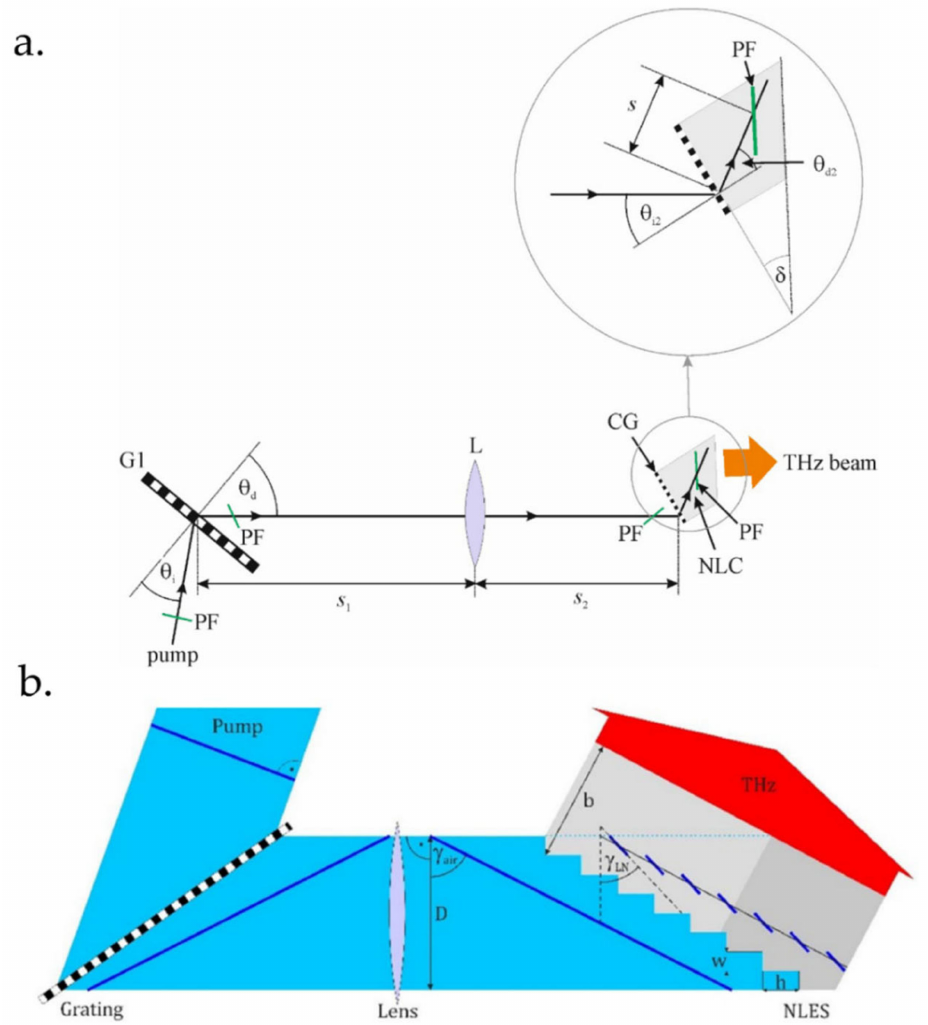
Figure 6. Schematic representation of the hybrid structure. ( a ) The hybrid structure uses transmission grating and lens and contact grating for TPF. ( b ) The transmission grating, lens and echelon surface on the LN tilt the pulse front (deep blue line) together. The average TPF in the LN crystal is shown by a grey solid line parallel with the pump incidence surface and the THz emitting surface of the NLES. [Reprinted/Adapted] with permission from [78,80], © The Optical Society. The advantages and disadvantages of different techniques of generating single- to few-cycle THz pulses are summarized in Table